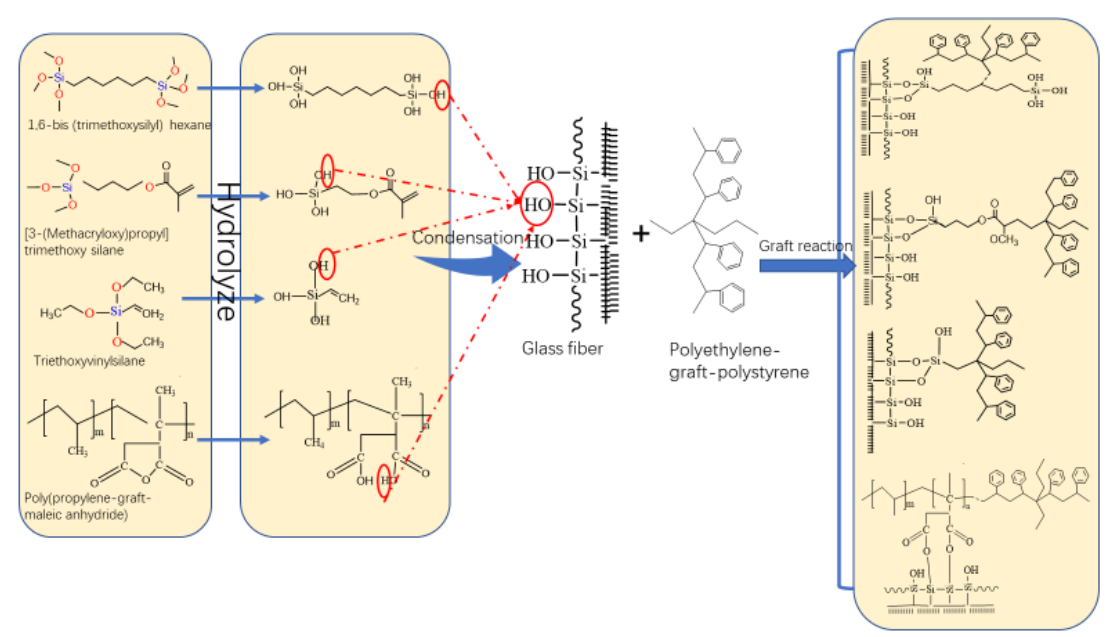
Figure 12. FT-IR spectrum of PE-g-PS-based composite with GF treated by different 3-MPS